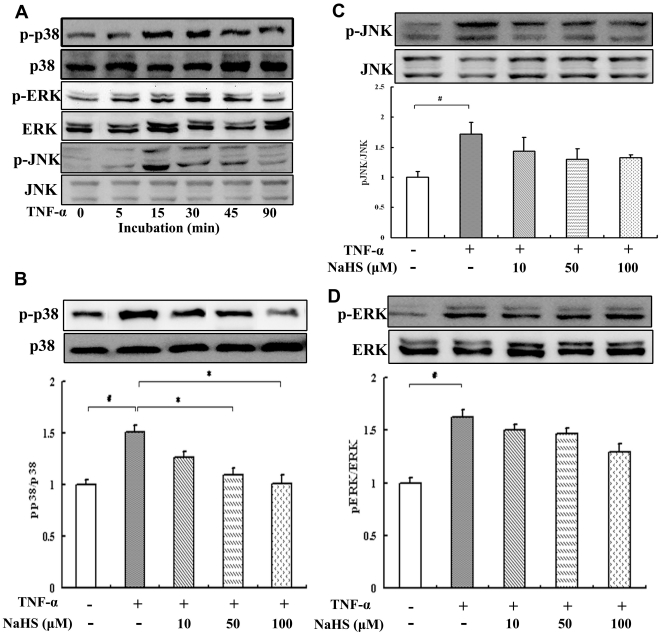
NaHS inhibited TNF-α-induced p38 phosphorylation.(A) HUVEC were stimulated with TNF-α (10 ng/ml) for indicated periods. The total and phosphorylation levels of MAPK were measured by Western blot. The experiment was repeated 3 times with equal results. Cells were incubated with indicated concentrations of NaHS for 30 min, then treated with TNF-α (10 ng/ml) for another 15 min. Phosphorylation levels of p38 (B), JNK1/2(C) and ERK1/2 (D) were analyzed by Western blot. #
P<0.05 compared with unstimulated cells, *P<0.05 compared with TNF-α-stimulated cells. Data are the mean ± S.E.M of results from at least three independent experiments, each performed in duplicate.